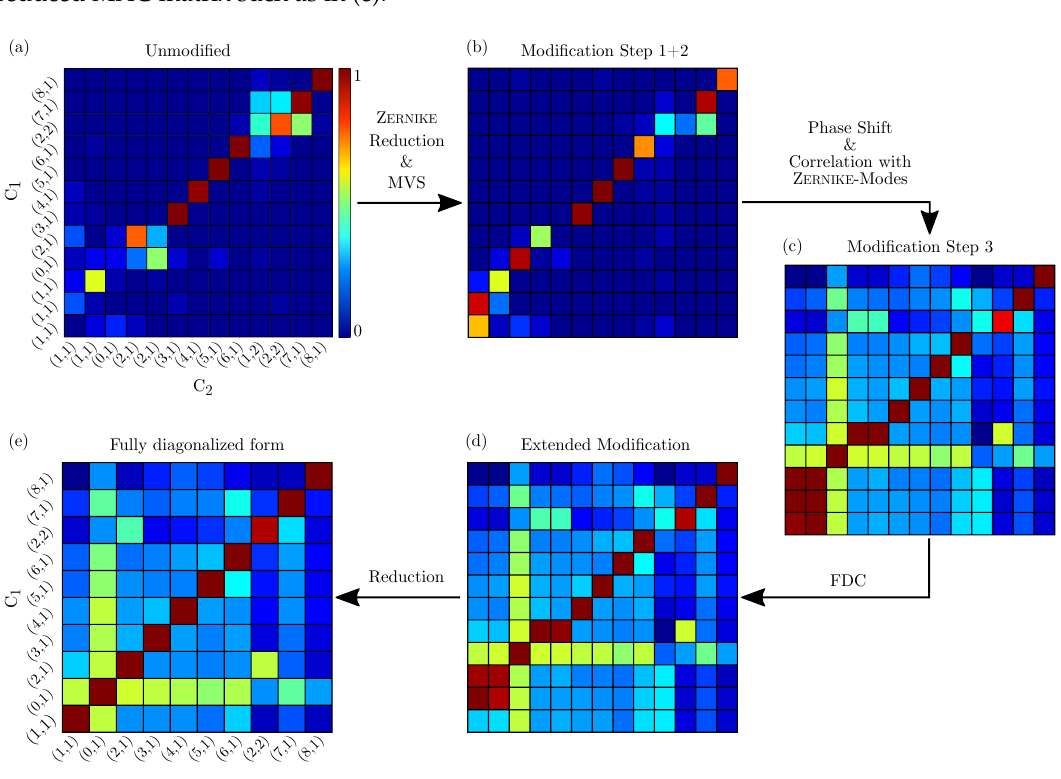
Figure 12. Several MAC matrices illustrate the correlation results of a rotor between two different conditions C 1 and C 2 and with different optimization methods applied, originating from unmodified eigenmodes ( a ), followed by enhancement methods such as Z ERNIKE reduction and maximum value shift (MVS) ( b ), phase angle modulation and direct correlation to Z ERNIKE modes ( c ), the extended correlation method FDC ( d ) and a final reduction steps ( e